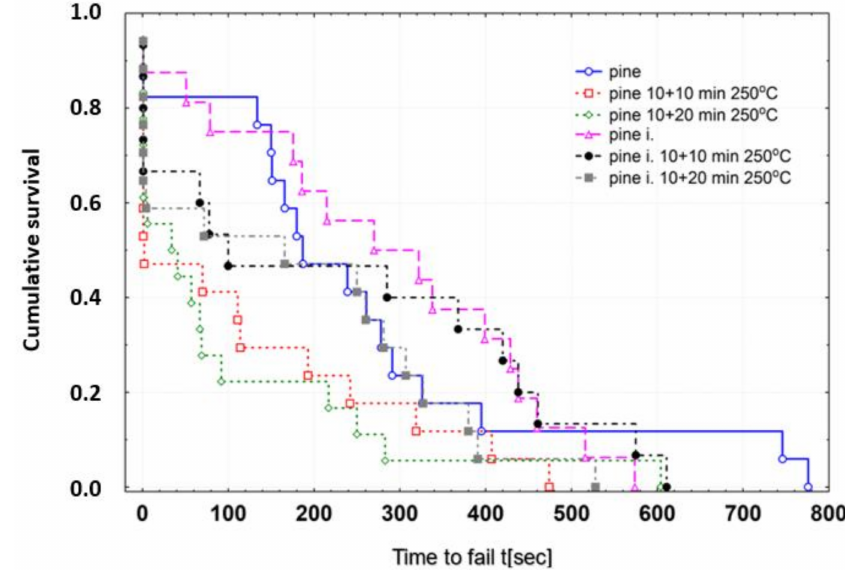
Figure 4. Distribution of the cumulative probability of survival as a function of time until